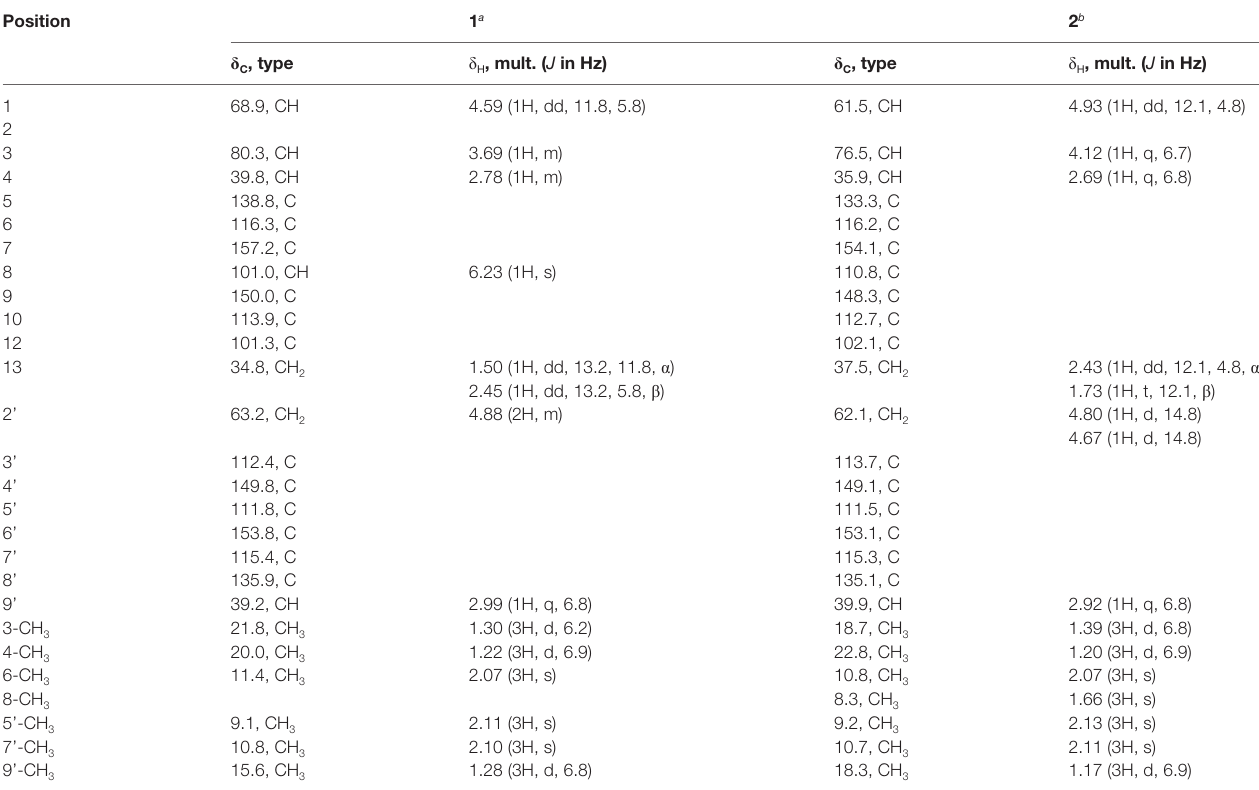
TABLE 1 | 1 H and 13 C NMR spectroscopic data for compounds 1 and 2 in CD 3 OD.